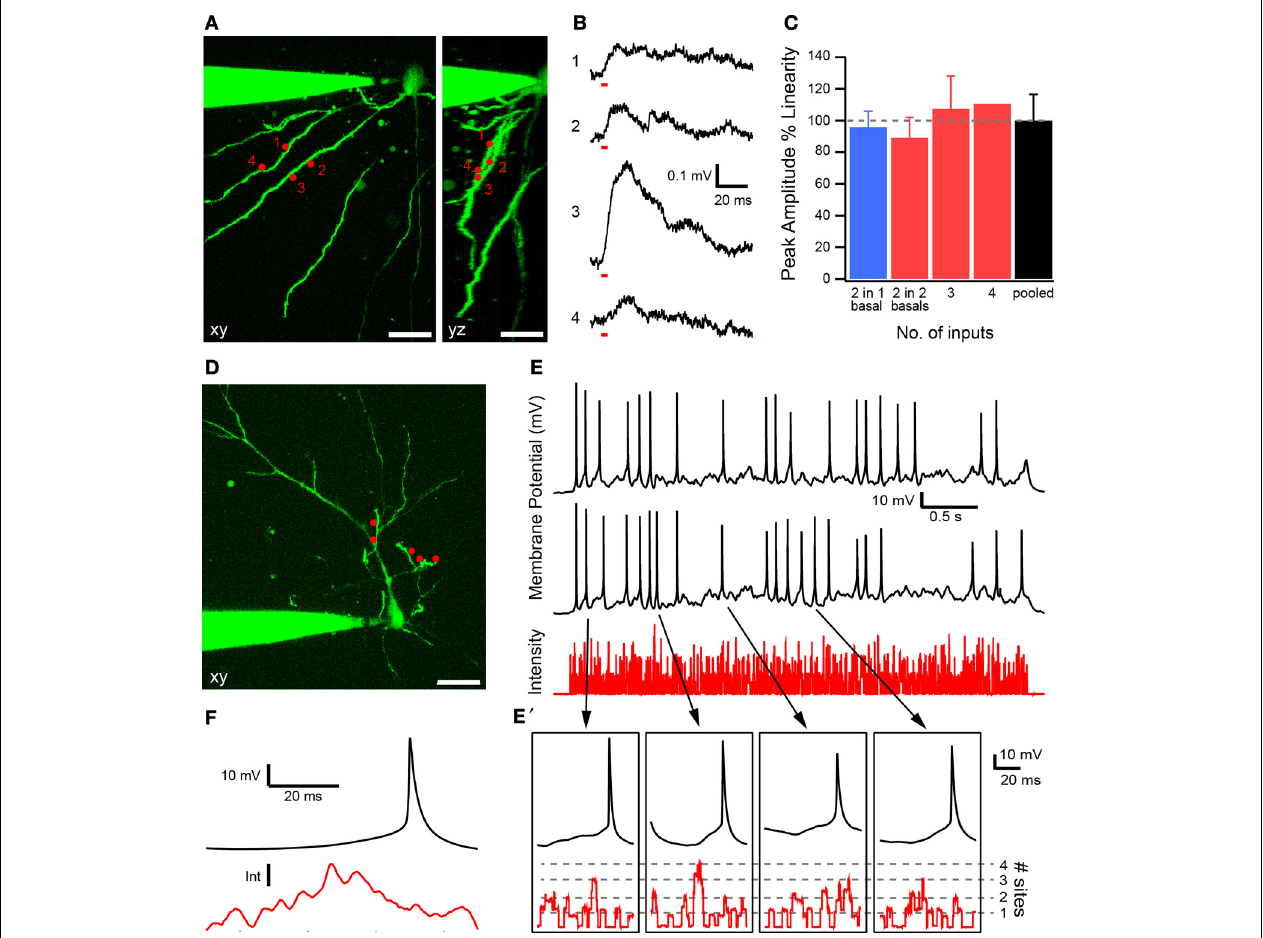
FIGURE 4 | Synaptic integration experiments. (A) Layer V pyramidal cell with uncaging sites in two planes 5 μ m apart (1 and 2 are in one plane, 3 and 4 in another) as viewed in the xy and yz planes. Scale bar 25 μ m. (B) Individual uncaging-evoked EPSPs obtained by turning ON stimulation sites in a static hologram one at a time with the DMD. Stimulus duration (3ms) is indicated by red bars at the start of the EPSP. (C) Summary of results for different combinations of uncaging sites. Linearity is expressed as the ratio of the peak amplitudes of the measured compound EPSP and the arithmetic sum of individual EPSPs. Dashed line denotes linear summation (100%). Blue bar corresponds to within-branch summation; red, between-branch summation. Data are shown as mean ± s.e.m. for all combinations. (D) Layer II/III pyramidal cell with five uncaging sites situated along three apical oblique